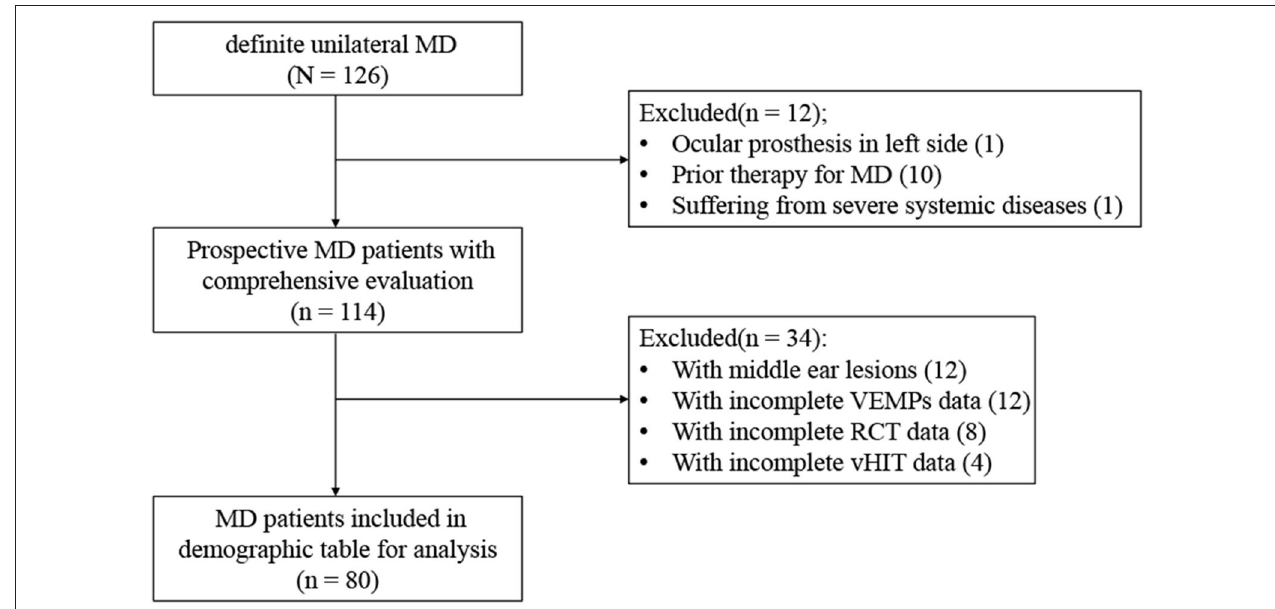
FIGURE 1 | Selection